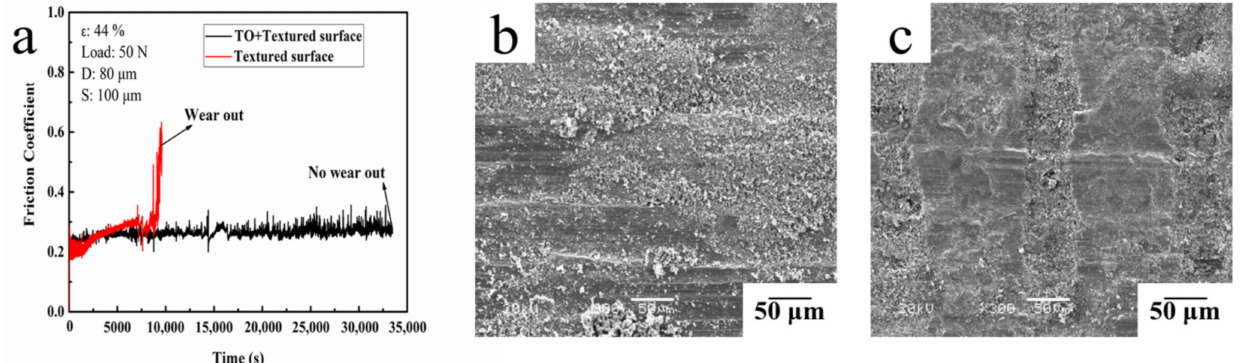
Figure 8. The fretting wear life ( a ) and SEM micrographs of textured surface ( b ) and TO+ textured surface ( c ).